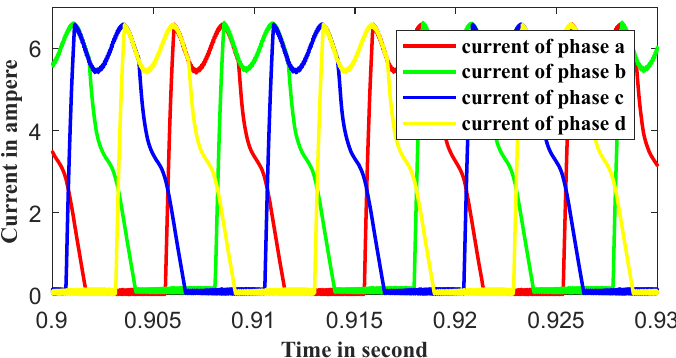
Figure 8. Stator current profile of 4-phase SRM drive using PI controller and MWAO algorithm.